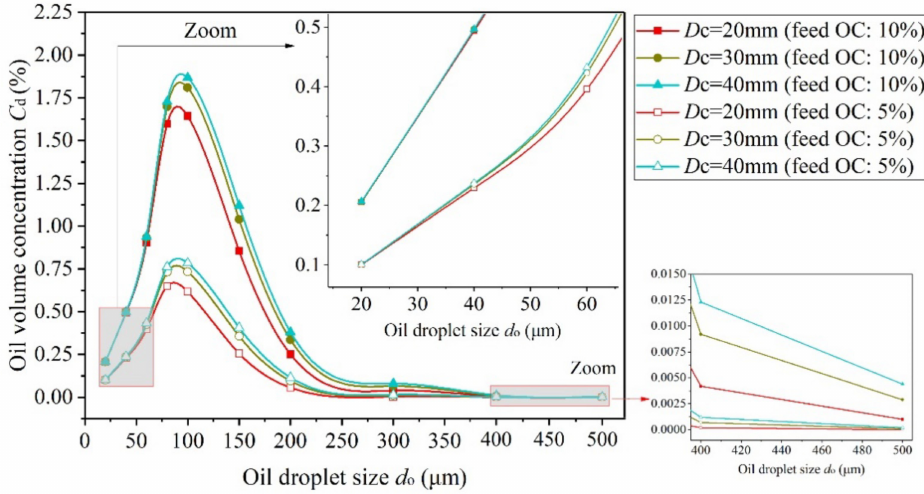
Figure 8. Average OC value curves at underflow